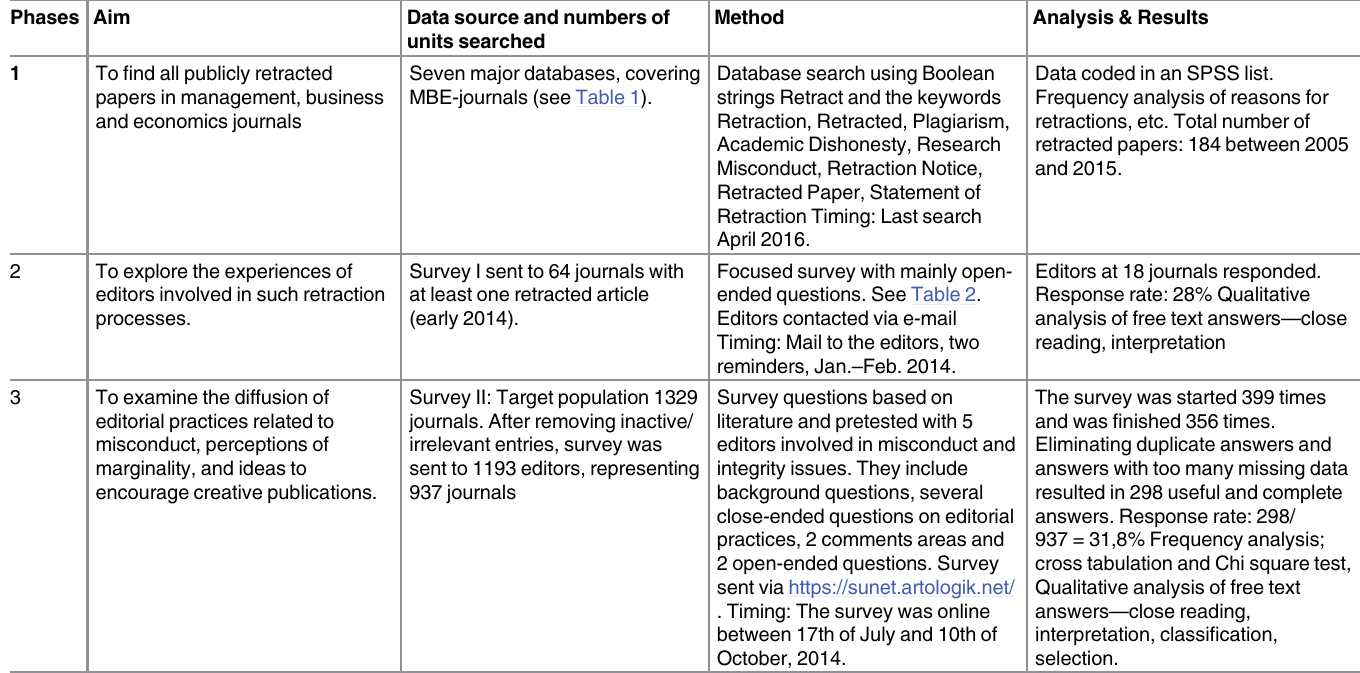
Table 4. Overview of data collection phases and